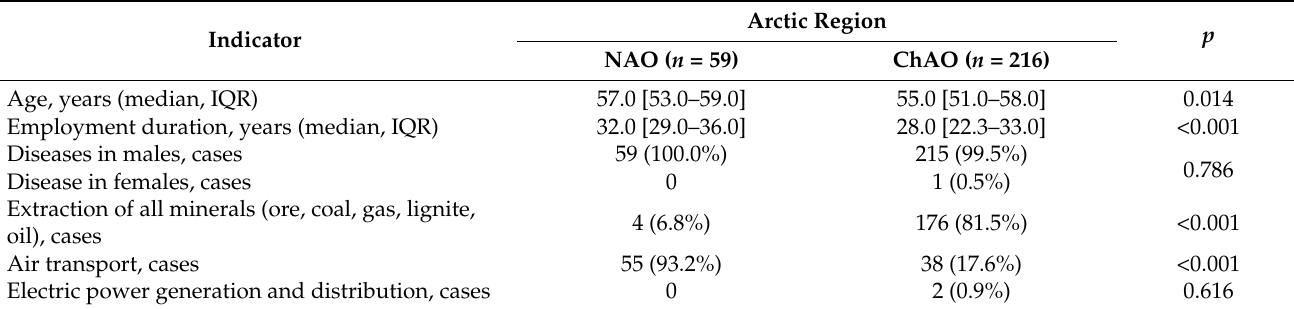
Table 3. General characteristics of workers with newly diagnosed occupational